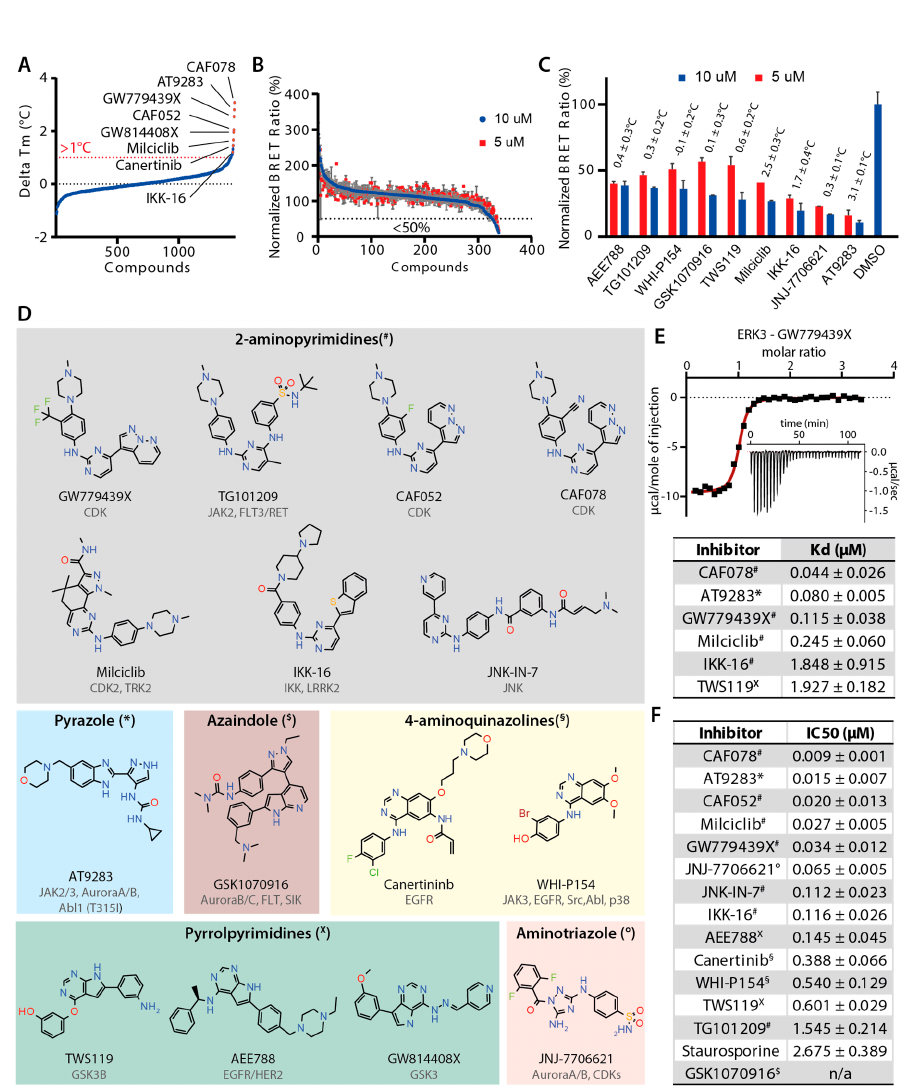
Figure 2. Identification of potential inhibitor ERK3. ( A ) Temperature shift results from inhibitor screening for ERK3. ( B ) The screening results from the NanoBRET assay. The normalized BRET ratio is calculated from the ratio between the BRET signal of the tested inhibitors and that of the DMSO control. The black dashed line indicates the normalized ratio at 50%. ( C ) Plots of the normalized BRET ratios for top hits (red and blue bars for 5 and 10 µM concentrations, respectively), with their measured temperature shift results displayed. ( D ) Chemical structures of the selected 13 inhibitors identified from both screenings, which are classified into six groups based on their hinge binding motifs. ( E ) Binding affinities of the inhibitors in ERK3 measured by isothermal calorimetry (ITC). Top: the binding isotherm of the ERK3-GW779439X titration (inset) and the integrated heat of binding, with the red line showing the fitting of single-site binding. Bottom: summary of ITC dissociation constant ( K d ) and thermodynamic parameters averaged over two replicates. ( F ) The NanoBRET IC 50 values for the inhibitors averaged over two replicates.